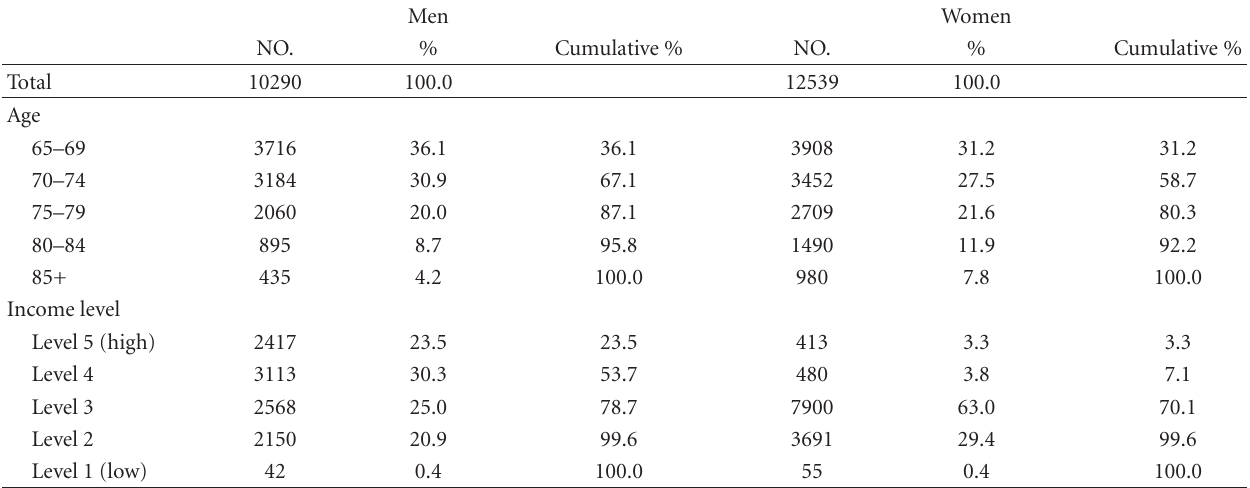
Table 2: Baseline distribution of data on age and income level.